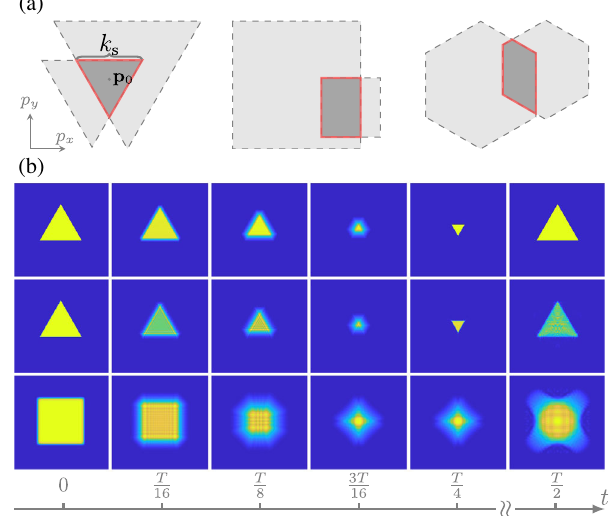
FIG. 3. Example II in 2D. (a) Schematic plots showing the unique property of triangles. The overlapped area of two homothetic equilateral triangles, as enclosed by the red triangle, is always another equilateral triangle, despite the sizes and relative position of these two. This geometric property does not hold for other shapes such as two homothetic squares or hexagons. (b) Dynamics of density distributions with initial density uniformly distributed inside an equilateral triangle, obtained by exact construction from the ideal-gas dynamics (top row) or by numerically solving the Gross-Pitaevskii equa- tions (middle row), and the same dynamics with initial density uniformly distributed inside a square (lower